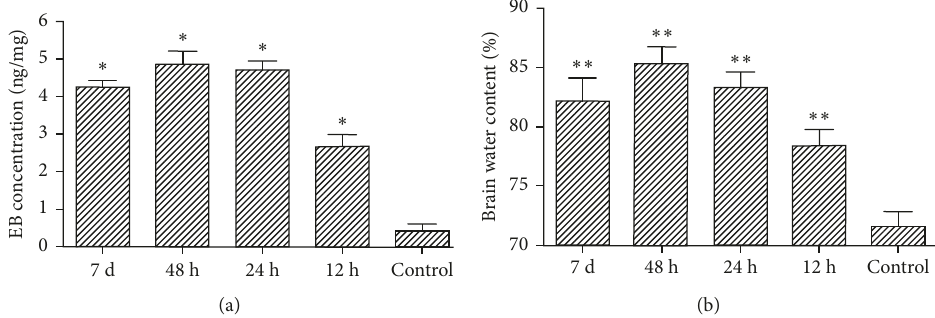
Figure 6: Changes in BBB permeability and BWC in brain tissues. (a) Effect of Streptococcus pneumoniae on EB extravasations. The amount of EB extravasation began to increase at 12 h after infection, and the peak value appeared at 24h and 48h, and then it had been recovering p since 7d after infection ( 0 . 05 compared with control rats’ brains; n The variation curve of brain tissue water content was similar to EB extravasations ( ∗ each <